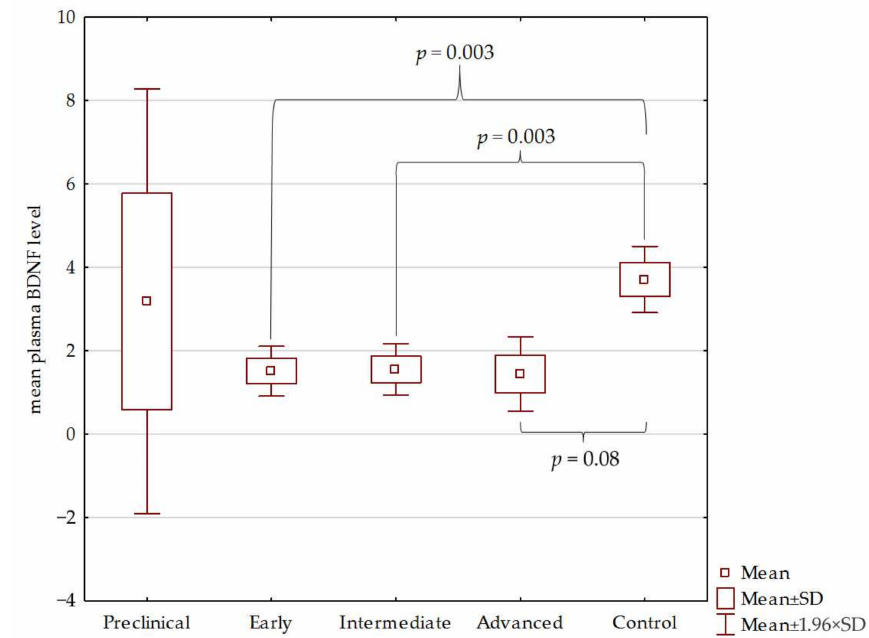
Figure 2. Plasma levels of BDNF in control group and individual HD stages. Table 3. Correlations between plasma levels of BDNF and neurological assessment determined using Spearman’s test. All HD Early Intermediate Correlations/HD Stages